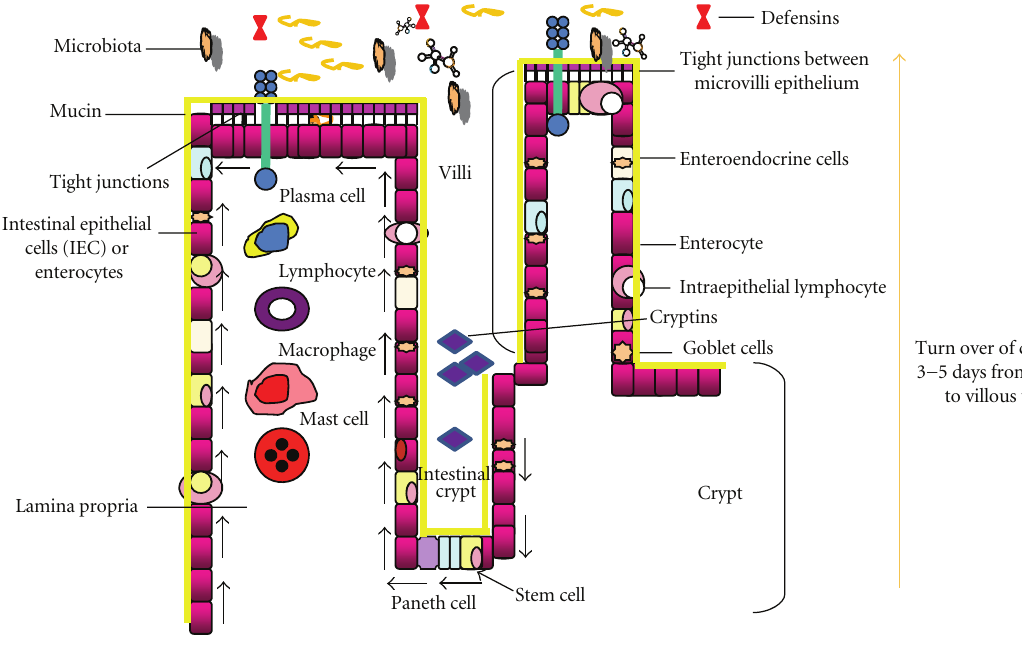
Figure 5: A depiction of the intestinal epithelial barrier. The intestinal epithelial barrier consists of a rapidly renewing epithelial cell population, derived from stem cells in the bases of intestinal crypts, that di ff erentiates into other epithelial cell types (Paneth cells, goblet cells, enteroendocrine cells, enterocytes, intra-epithelial lymphocytes, and M cells). These cells, as they are produced in the crypts, migrate to the tips of the villi over approximately 3 to 5 days. This process of repair and restitution can be influenced by cellular signaling pathways initiated by the intestinal microbiota. (Modified from Sharma R, Young C, Mshvildadze M, Neu J. Intestinal Microbiota Does It Play a Role in Diseases of the Neonate? NeoReviews Vol.10 No.4 2009 e166 , with